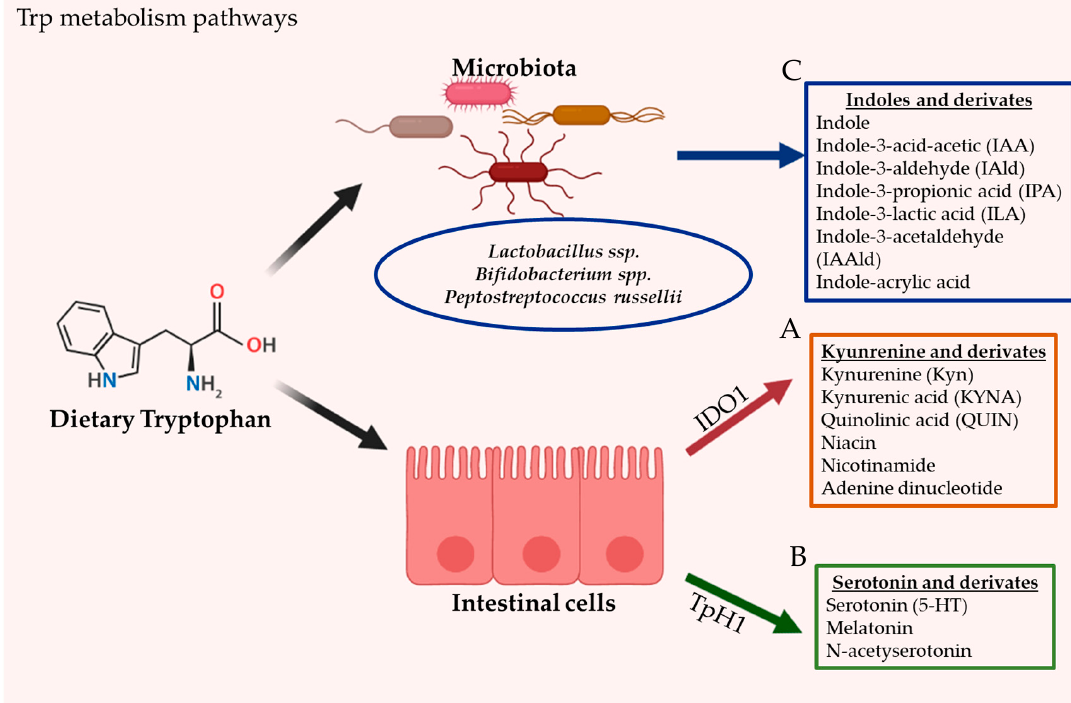
Figure 1. The gastrointestinal tract is the principal location of tryptophan (Trp) metabolism. In humans, Trp is acquired exclusively through dietary intake. Dietary Trp can be processed by three main metabolism routes: ( A ) the kynurenine pathway (KP), which mainly occurs in both immune and epithelial cells via IDO1, leading to several kynurenine metabolites (KYNs) including ligands for AhR ( B ) the serotonin production pathway, taking place in enterochromaffin cells (subtype of intestinal epithelial cells) and via TpH1, and finally ( C ) the direct conversion of Trp by the gut microbiota into several Indoles and derivates, including ligands of the AhR.